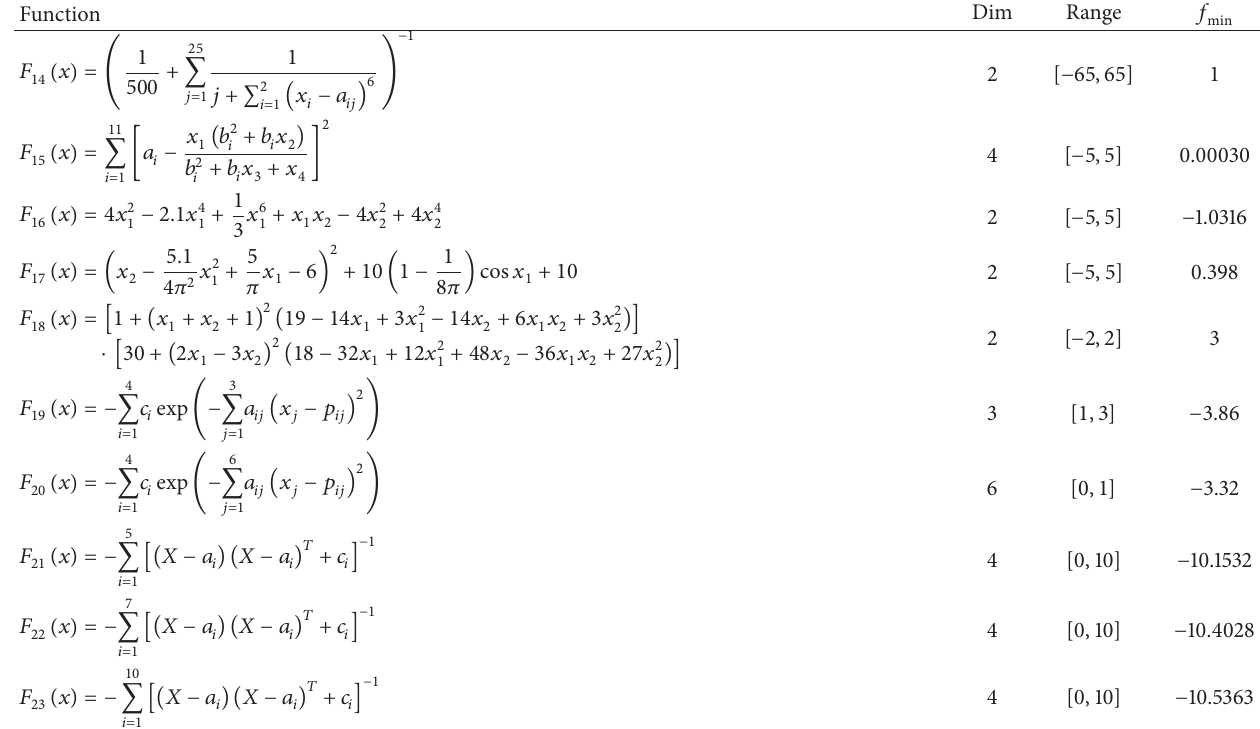
Table 3: Fixed-dimension multimodal benchmark